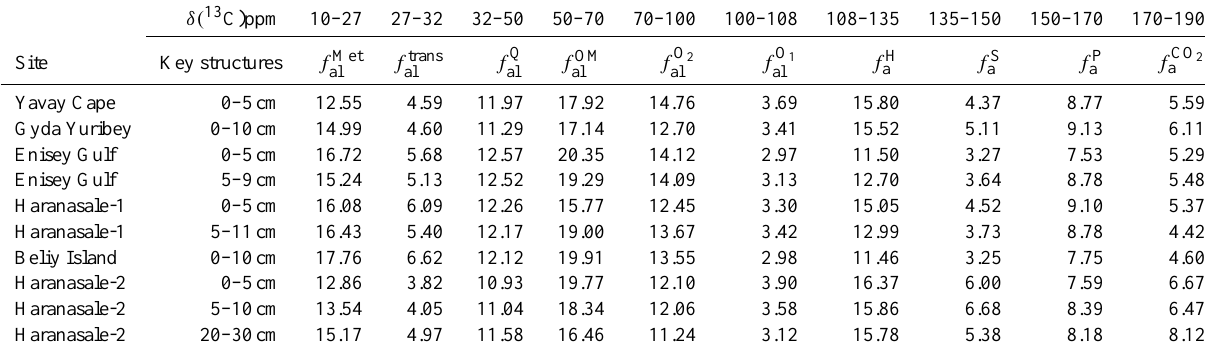
Table 3. 13 C-NMR section integrals (percent of total carbon) for key carbon structures of soil humic acids. δ( 13